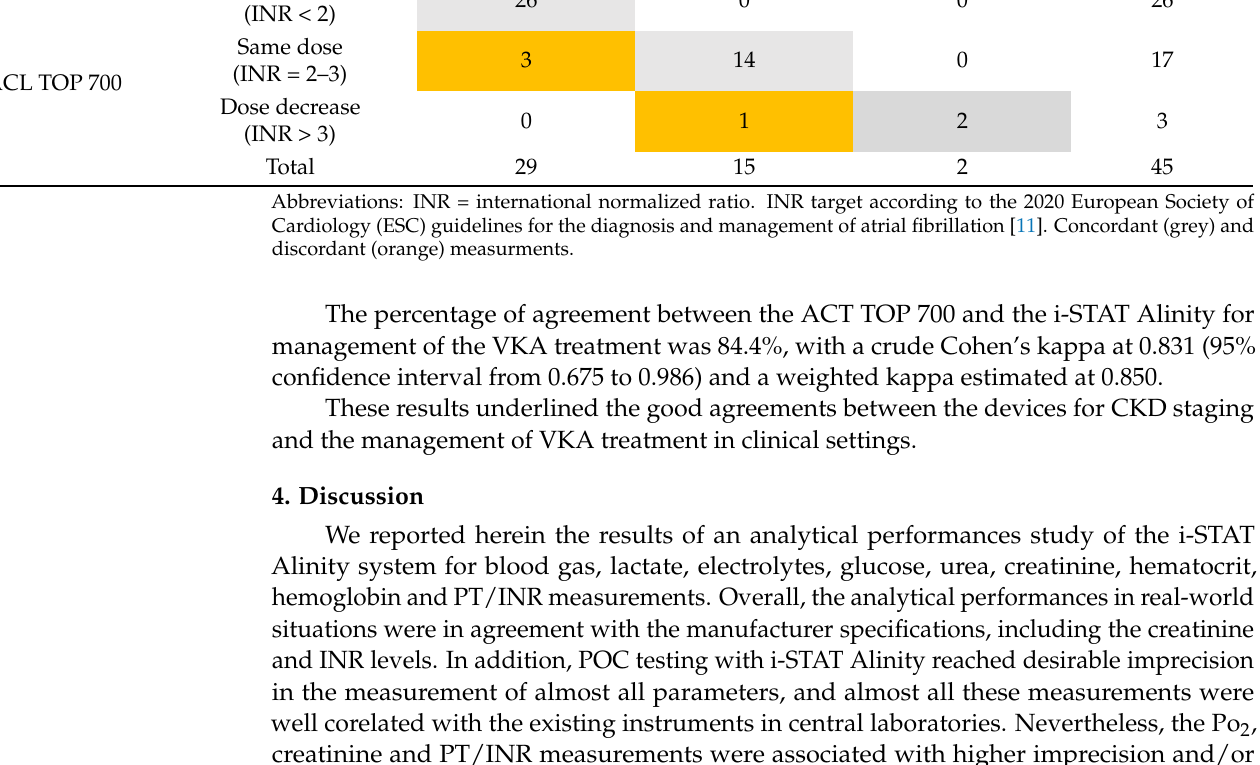
Table 4. Concordance with antivitamin K drug regimen changes induced by the international normalized ratio (INR) measurements by the i-STAT Alinity system (Abbott laboratories, Chicago, IL, USA) and ACL TOP 700 analyzer (Werfen, Barcelona, Spain) in 46 patients. i-STAT Alinity Change in Antivitamin K